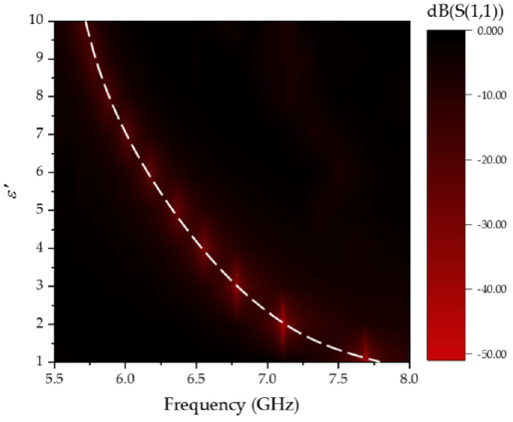
Figure 10. The resonant frequency curve varies with the permittivity.